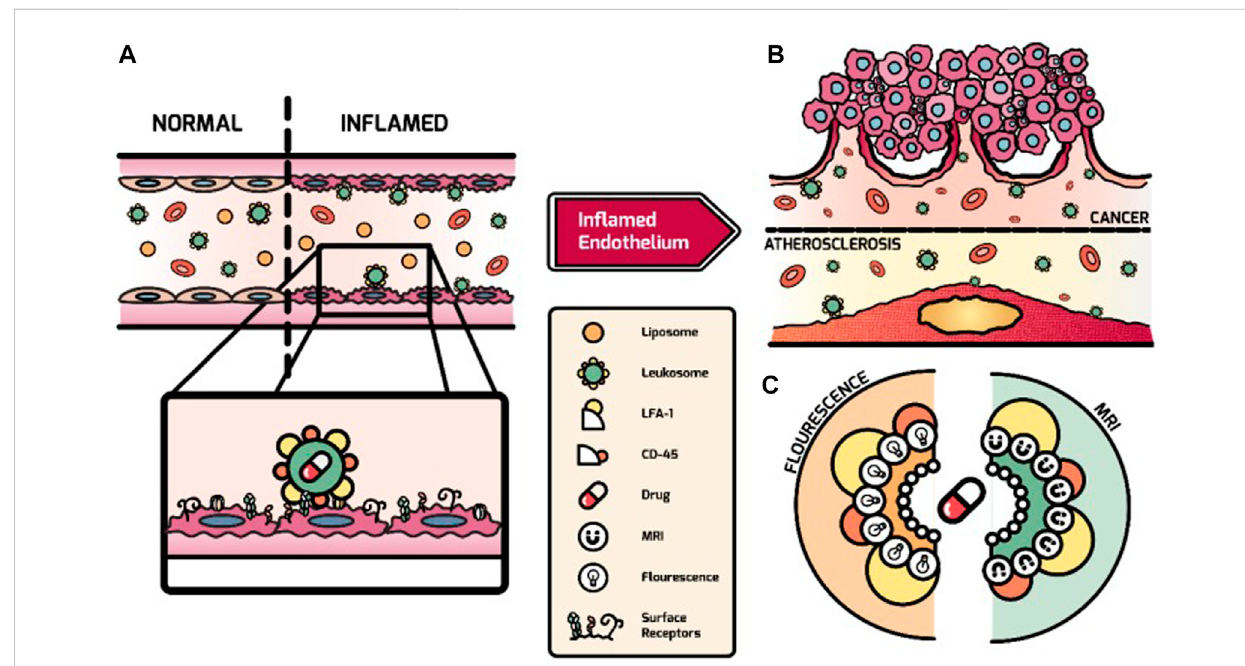
FIGURE 3 Overview of the targeting process of leukosomes to activated endothelium. (A) Mediated by LFA-1 and CD45, leukosomes can selectively bind to activated endothelium after systemicadministration. (B) Leukosomes experience effective targeting ofatherosclerosisand cancer-relatedin fl ammation. (C) The imaging modalities (e.g., fl uorescence dyes and Gd) and therapeutics can be incorporated by leukosomes with their versatility (Martinez et al., 2018). Copyright © 2018,